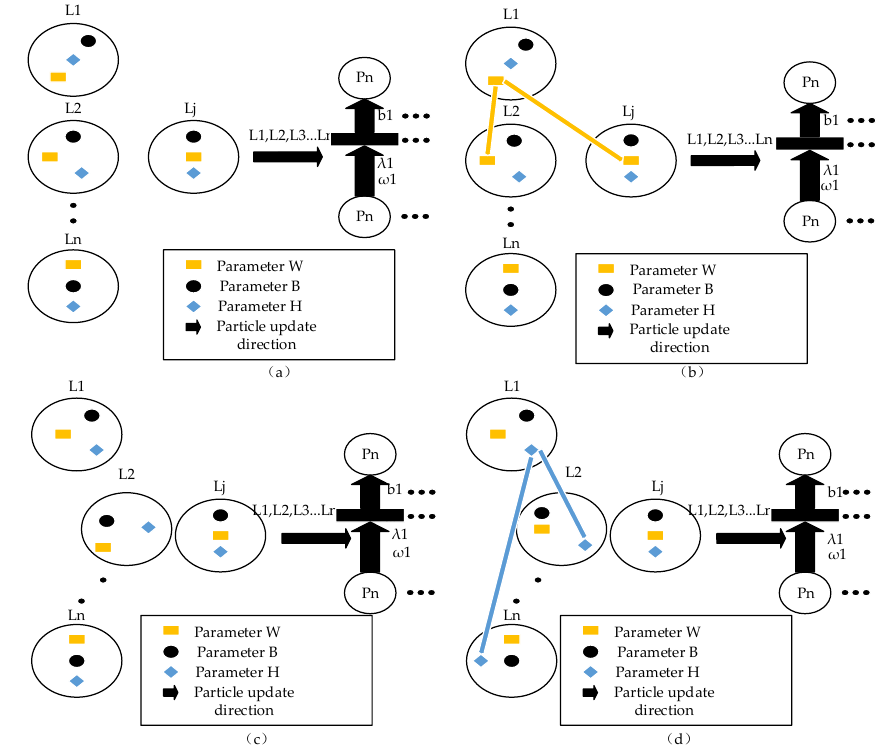
Figure 7. Parameter generation process based on CLPSO.